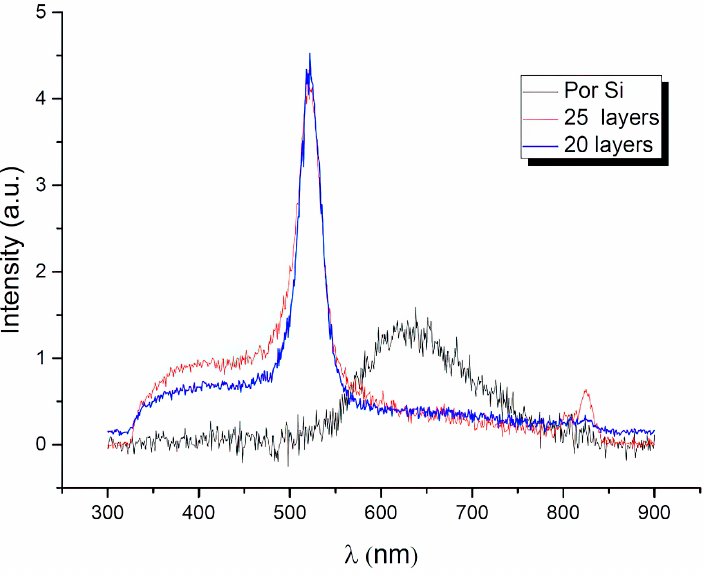
Figure 10. PL spectra of the initial sample and with ZnO coating.